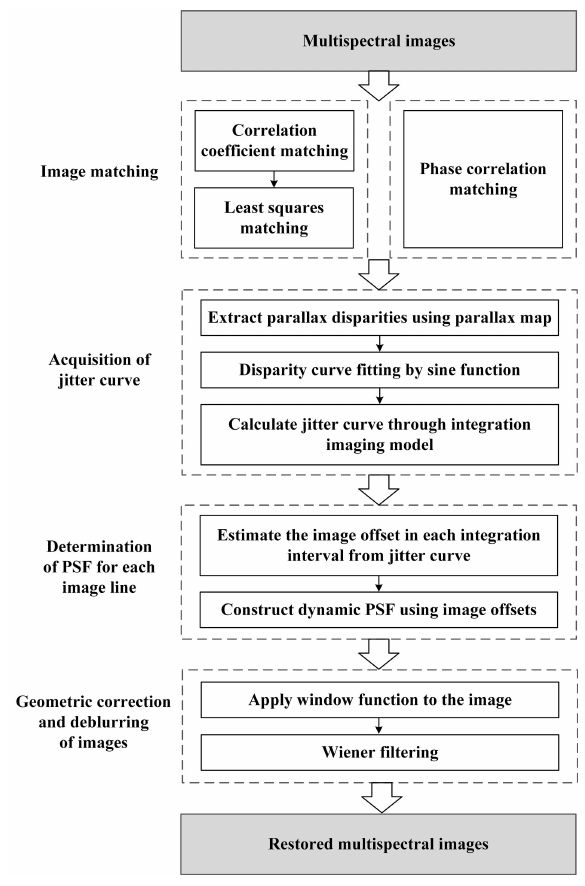
Figure 2 . Overall framework of jitter